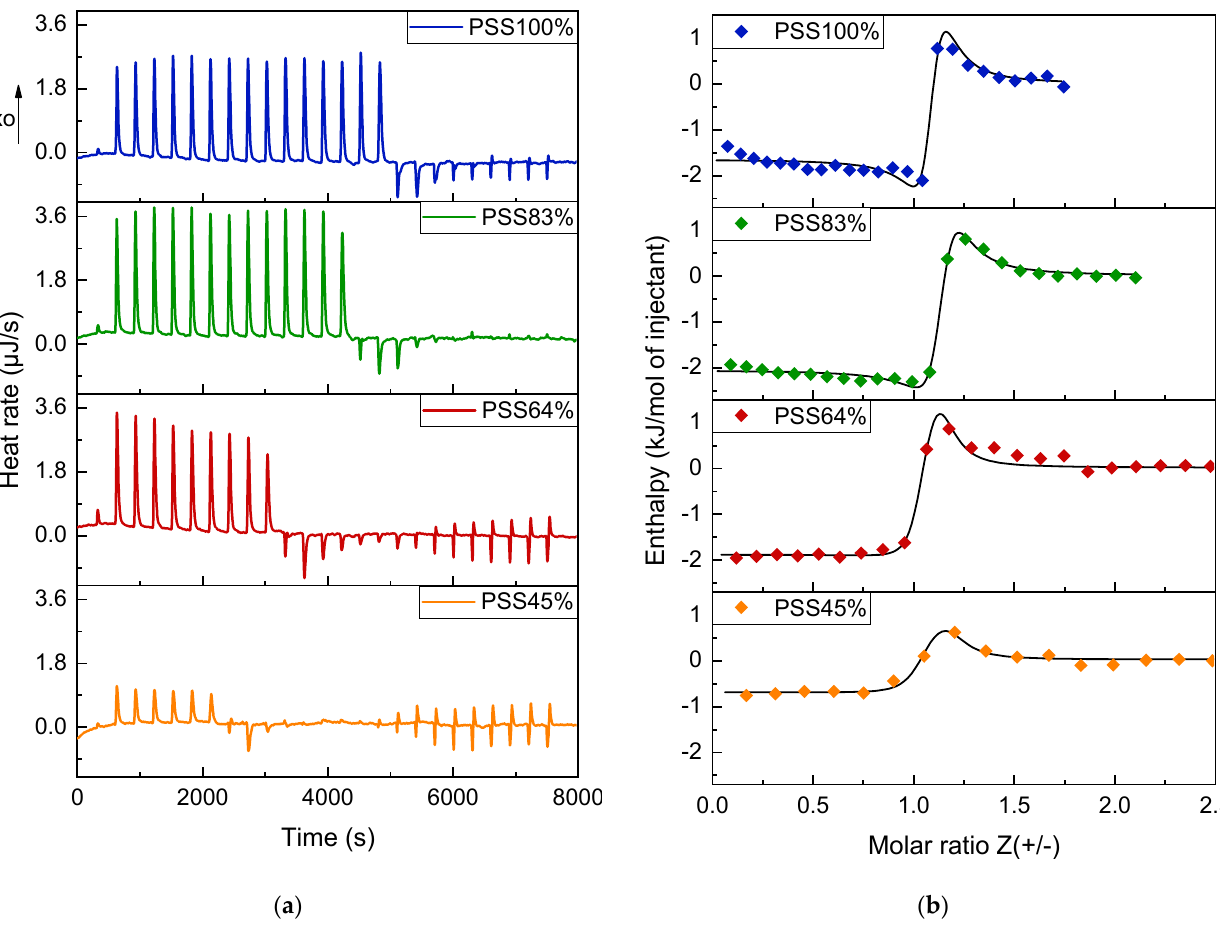
Figure 9. ITC raw data and binding isotherms obtained for the PDADMAC-P(St-co-SSNa) complex- ation. ( a ) Corrected heat rates obtained for the titration of PDADMAC (6 mM in monomers) into P(St-co-SSNa). The concentration of P(St-co-SSNa was 1 mM in monomers (charged and uncharged units), which explains the apparent lower binding stoichiometry before converting concentrations to Z); ( b ) binding isotherms corresponding to the various titration experiments as function of Z. The solid line represents the best fit curve derived from a two independent binding site model.